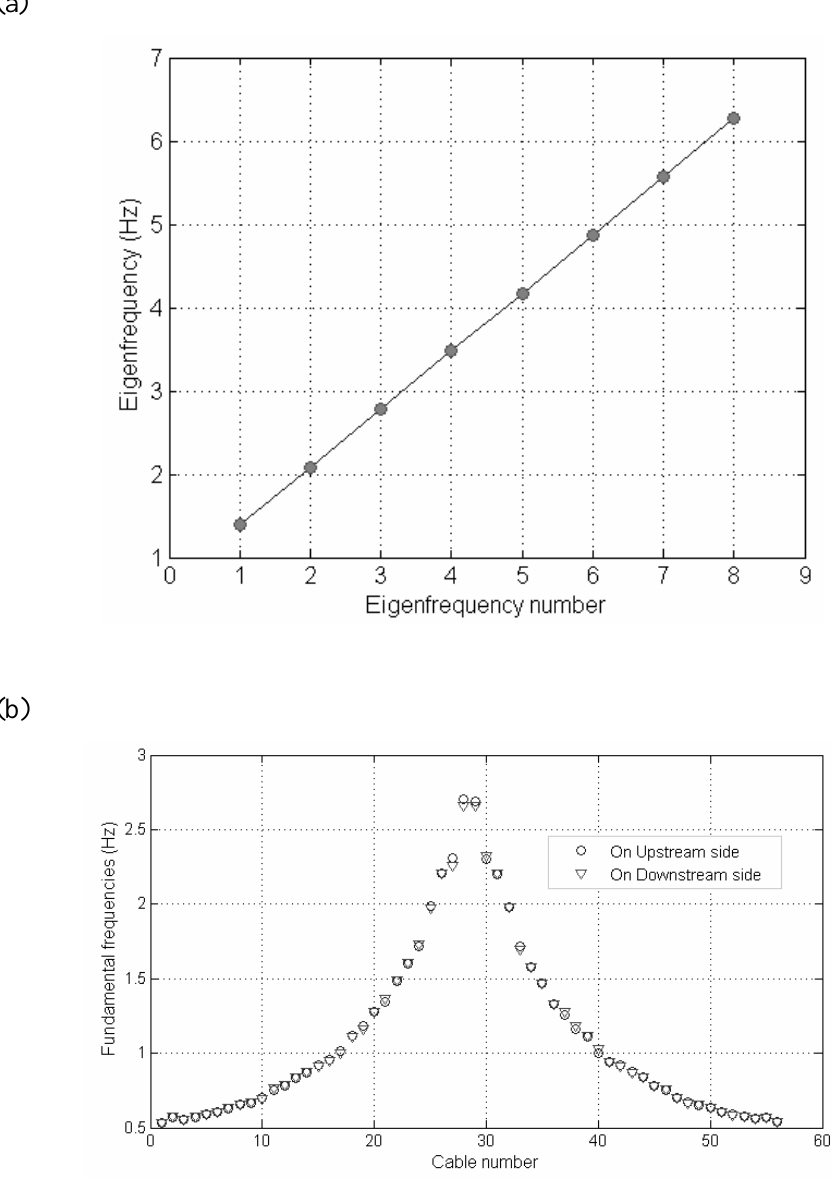
Fig. 8. (a) Fundamental cable frequency; (b) Fundamental cable frequency of all stay cables for the Jinma